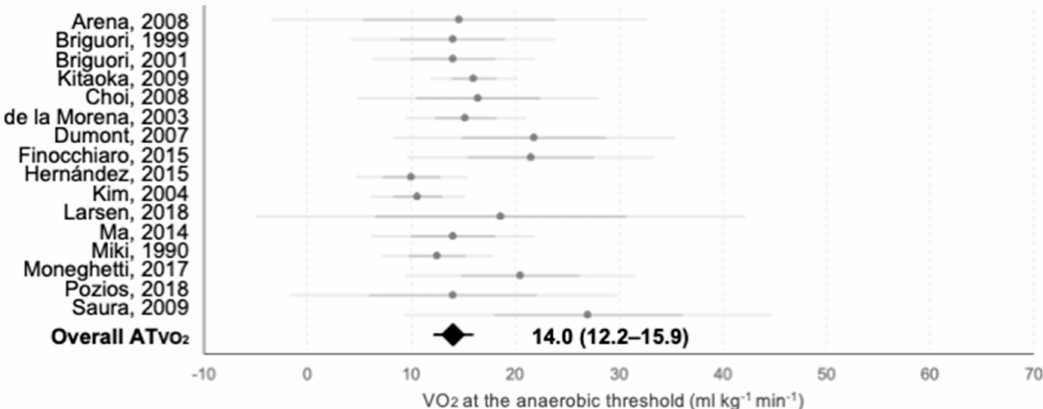
Figure 3. Meta-analysis of the ATVO2 reported on each study. Grey points represent Table 2 of each individual study. Darker horizontal lines intersecting them represent the upper and lower value of the mean ± SD, and lighter horizontal lines show 95% CI. The black rhombus represents the mean value and 95% CI of all studies as extracted from the meta-analysis. Numerical values for the whole group are